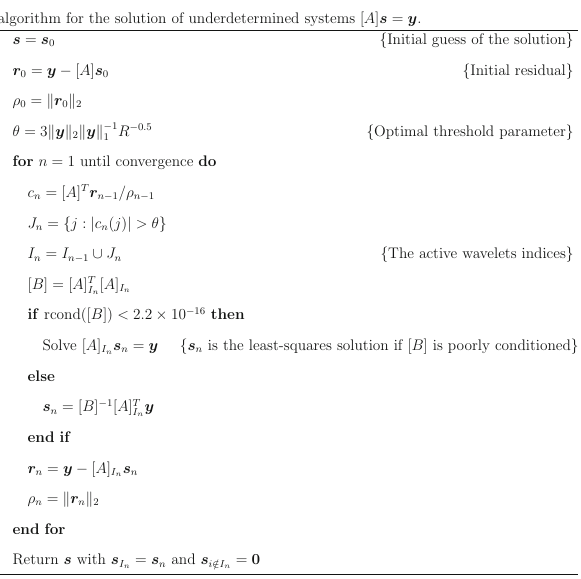
algorithm for the solution of underdetermined systems [ A ] s = y . s = s 0